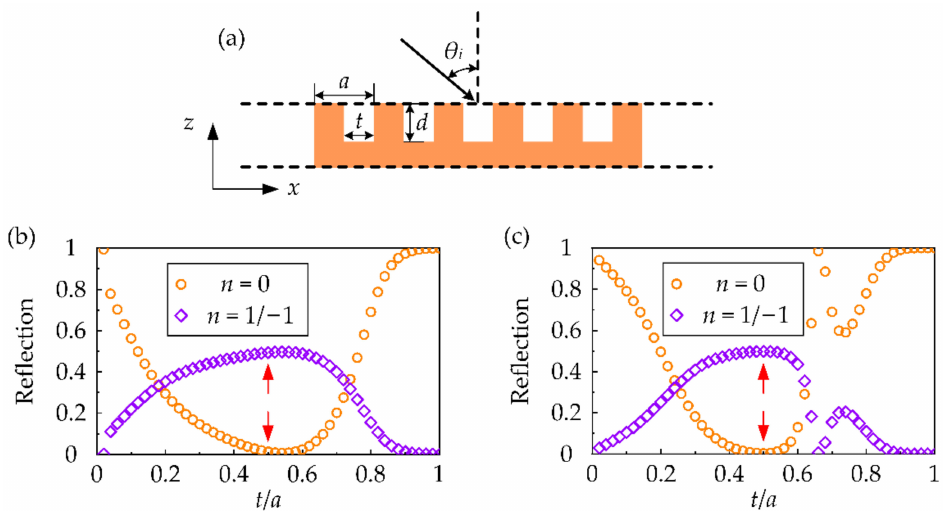
Figure 2. ( a ) Schematic illustration of the proposed ABM, which is constructed by etching one straight-walled groove per period on a planar hard surface. The periodicity is along the x direction, and the period length is a . The depth and width of the groove in each period are denoted as t and d , respectively. Simulated reflection responses as a function of the ratio t / a ( b ) in the case of a = 1.4 λ 0 and ( c ) in the case of a = 1.8 λ 0 . Here, d = 0.25 λ 0 , λ 0 = 100